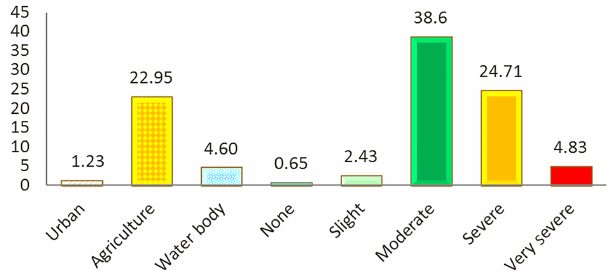
Figure 5. Percent of the land which is classified under each severity class of desertification in the study